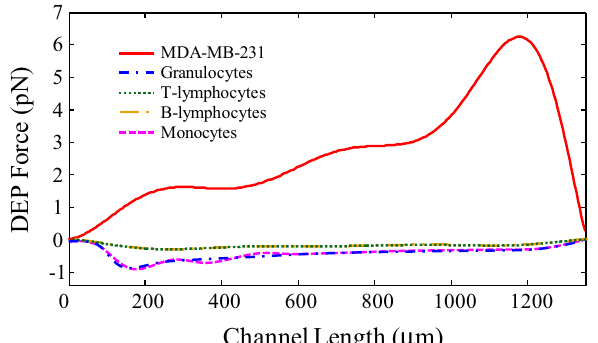
Figure 10. Applied DEP force on MDA-MB-231 and different subtypes of WBCs along the x-direction in a semi-circular